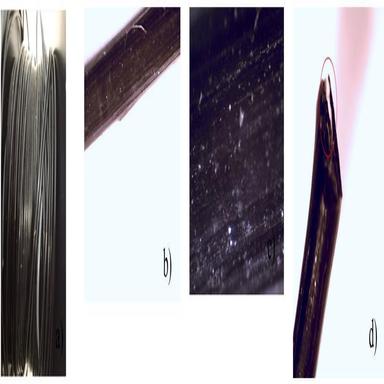
Pictures of W10 with different magnifications: a) 1x; b) 20x; c) x100; d) a white nylon 6 inclusion in evidence (20x).